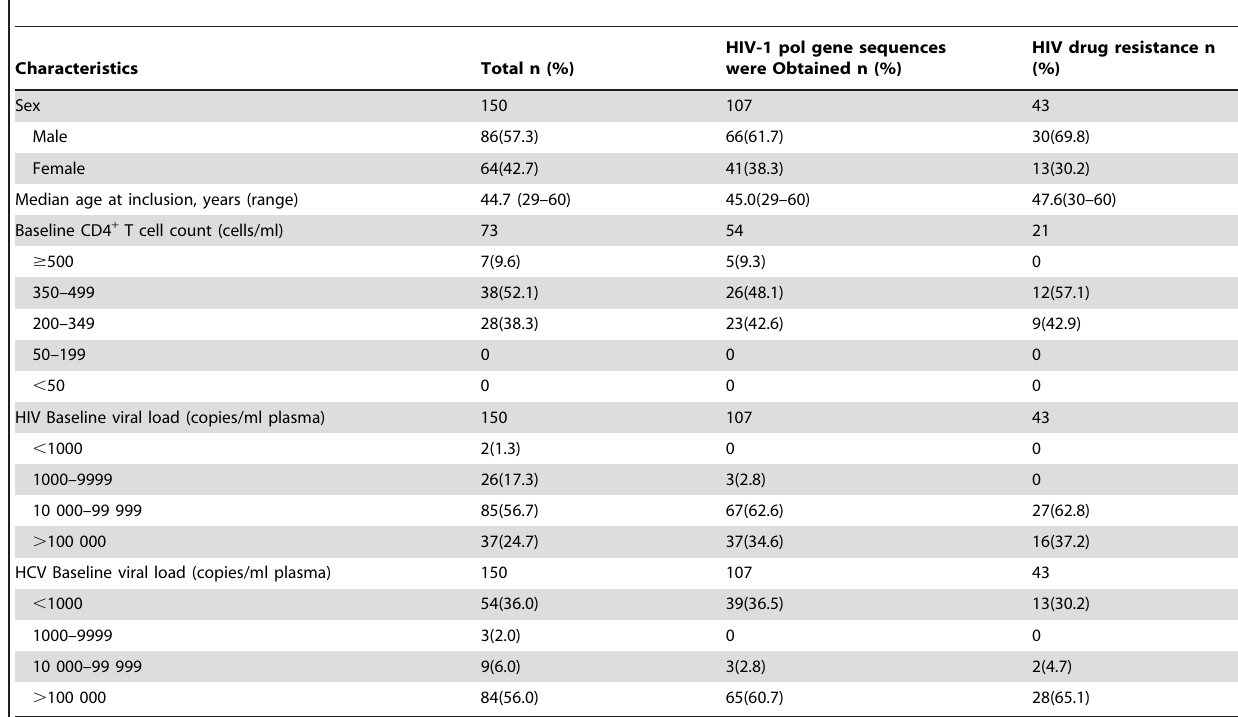
Table 2. Characteristics of treatment-naive HIV-infected study population in former paid blood donors in Henan province, China.